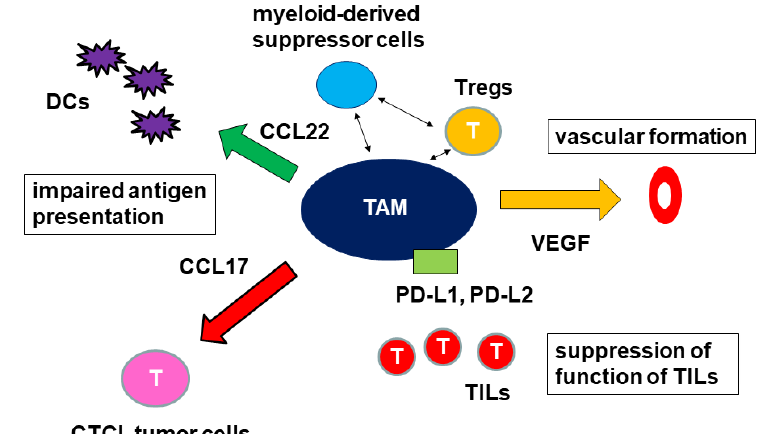
Figure 3. Role of macrophages in skin malignancy. Macrophages interact with Tregs and myeloid-derived suppressor cells, suppressing tumor immunity. Macrophages also mediate vascular formation and chemotaxis of tumor